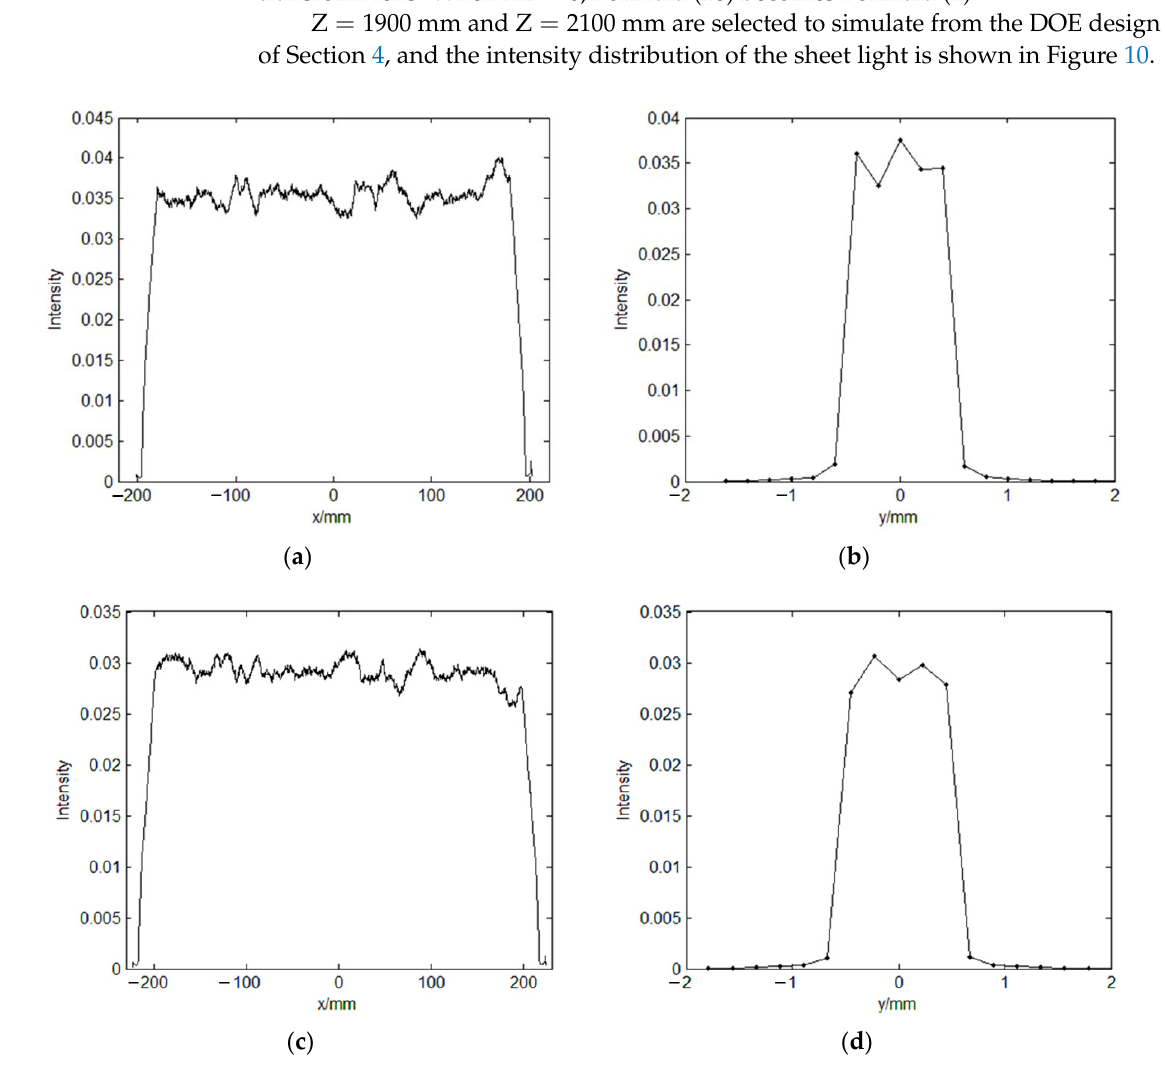
Figure 10. Intensity distribution at Z = 1900 mm and Z = 2100 mm. ( a ) Intensity distribution along X axis at Z = 1900 mm; ( b ) intensity distribution along Y axis at Z = 1900 mm; ( c ) intensity distribution along X axis at Z = 2100 mm; ( d ) intensity distribution along Y axis at Z = 2100 mm.